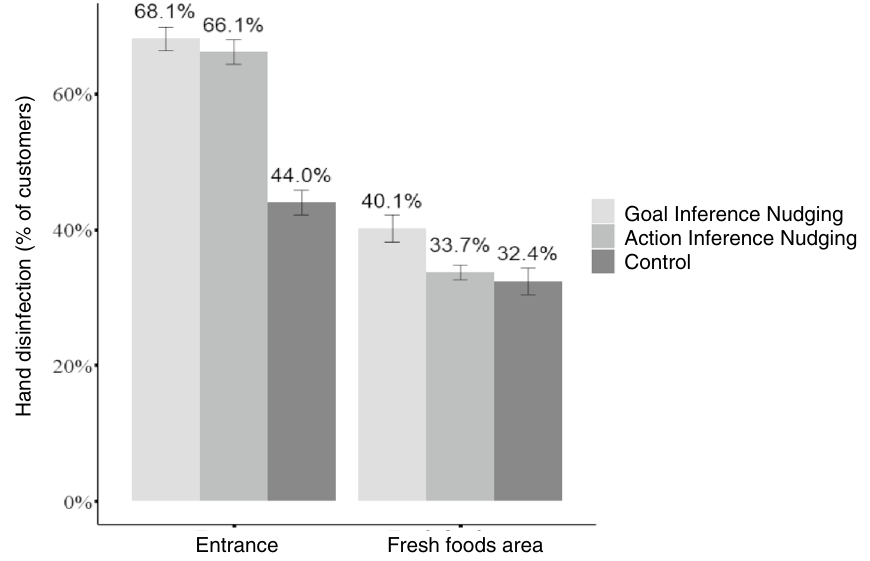
Figure 3. Hand disinfection in Study 3 at the store entrance (nudging site) and fresh foods area (generalization site) by condition. This figure displays the proportion of customers disinfecting their hands in each condition. Error bars represent ± 1 standard error of the